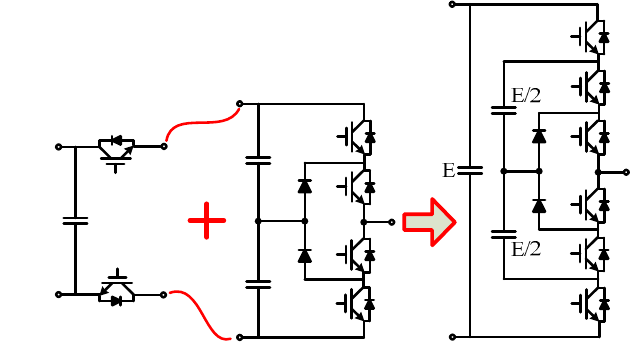
Figure 7. Derivation process of 4L NNPC converter. Energies 2016 , 9 , x